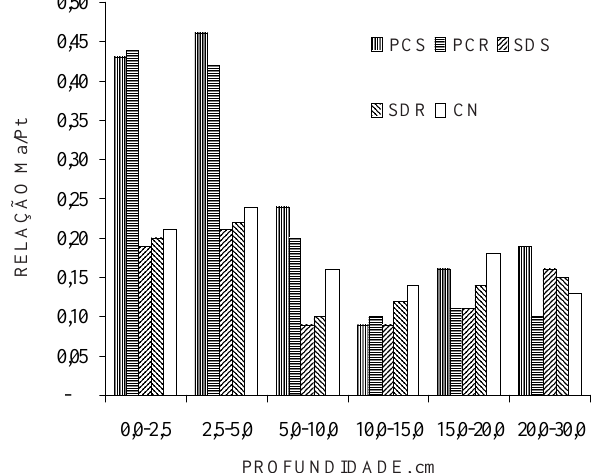
Figura 2. Relação volume de macroporos (Ma)/ volume total de poros (Pt) em diferentes profundidades, em um Cambissolo Húmico alumínico léptico submetido a diferentes sistemas de manejo e cultivo. PCS: preparo convencional sucessão de culturas; PCR: preparo convencional rotação de culturas; SDS: semeadura direta sucessão de culturas; SDR: semeadura direta rotação de culturas; CN: campo